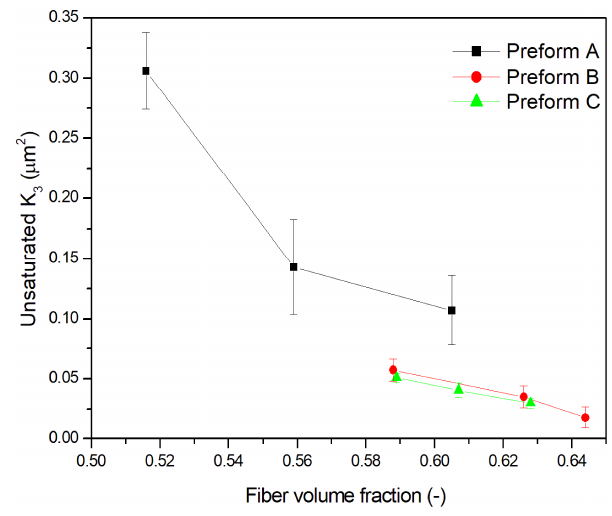
Figure 7. Unsaturated out-of-plane permeability as a function of fiber volume fraction.